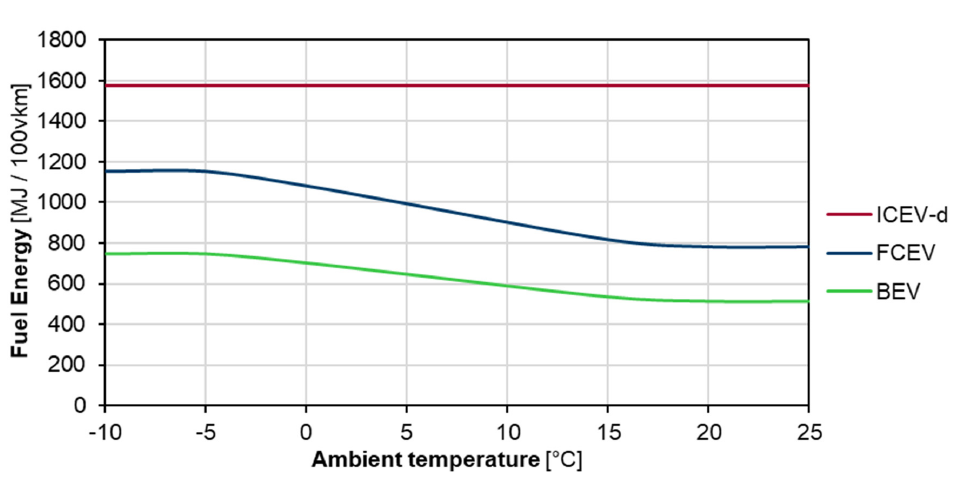
Figure 17. Fuel energy demand for medium buses for varying ambient